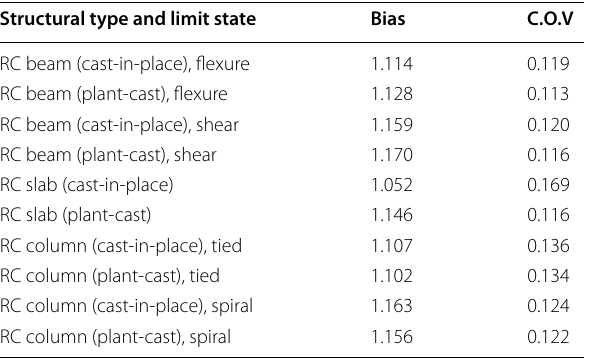
Table 6 Statistical parameters of resistance, R Nowak, 2003) Structural type and limit